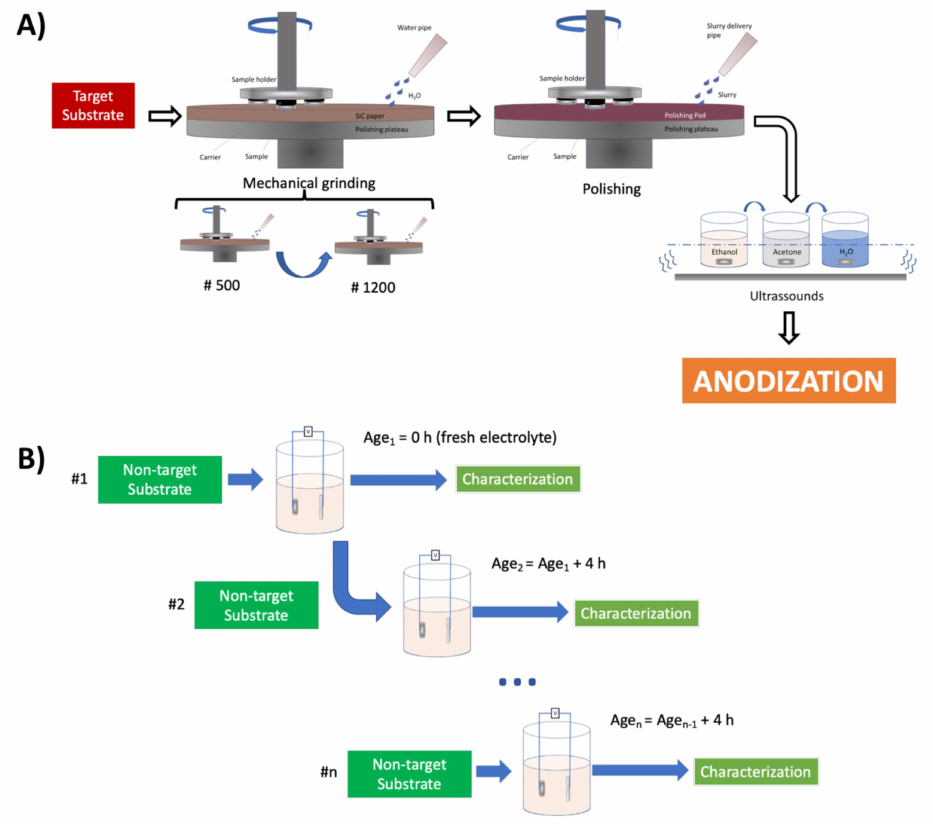
Figure 1. Schematic representation of ( A ) the process of specimen preparation prior to anodization and ( B ) electrolyte aging (#n: number n of anodizations performed in the same